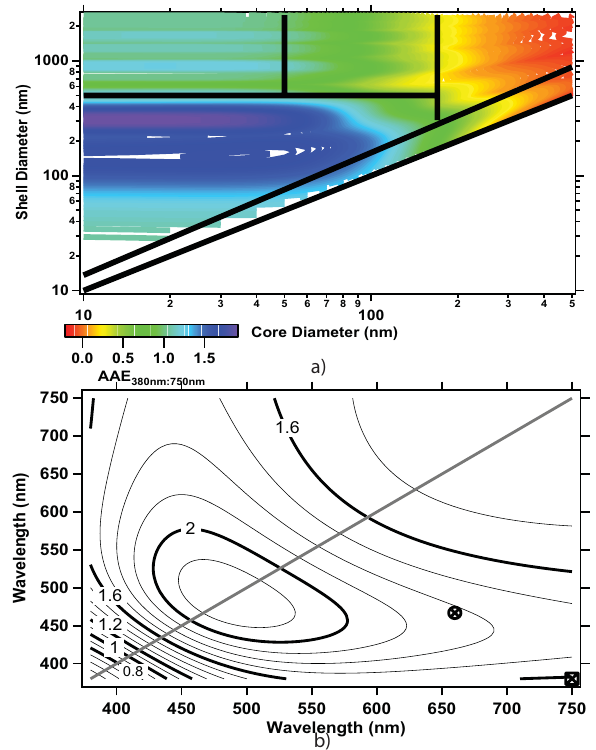
Fig. 8. (a) Modeled AAE 380nm − 750nm for variable core diameter and C Clear shell thicknesses. (b) Modeled AAE as a function of wavelength choice for a 60nm core and 330nm diameter coating (central values of regime 3). The black square and black circle in- dicates wavelength combinations used in this study and Bergstrom et al. (2007)